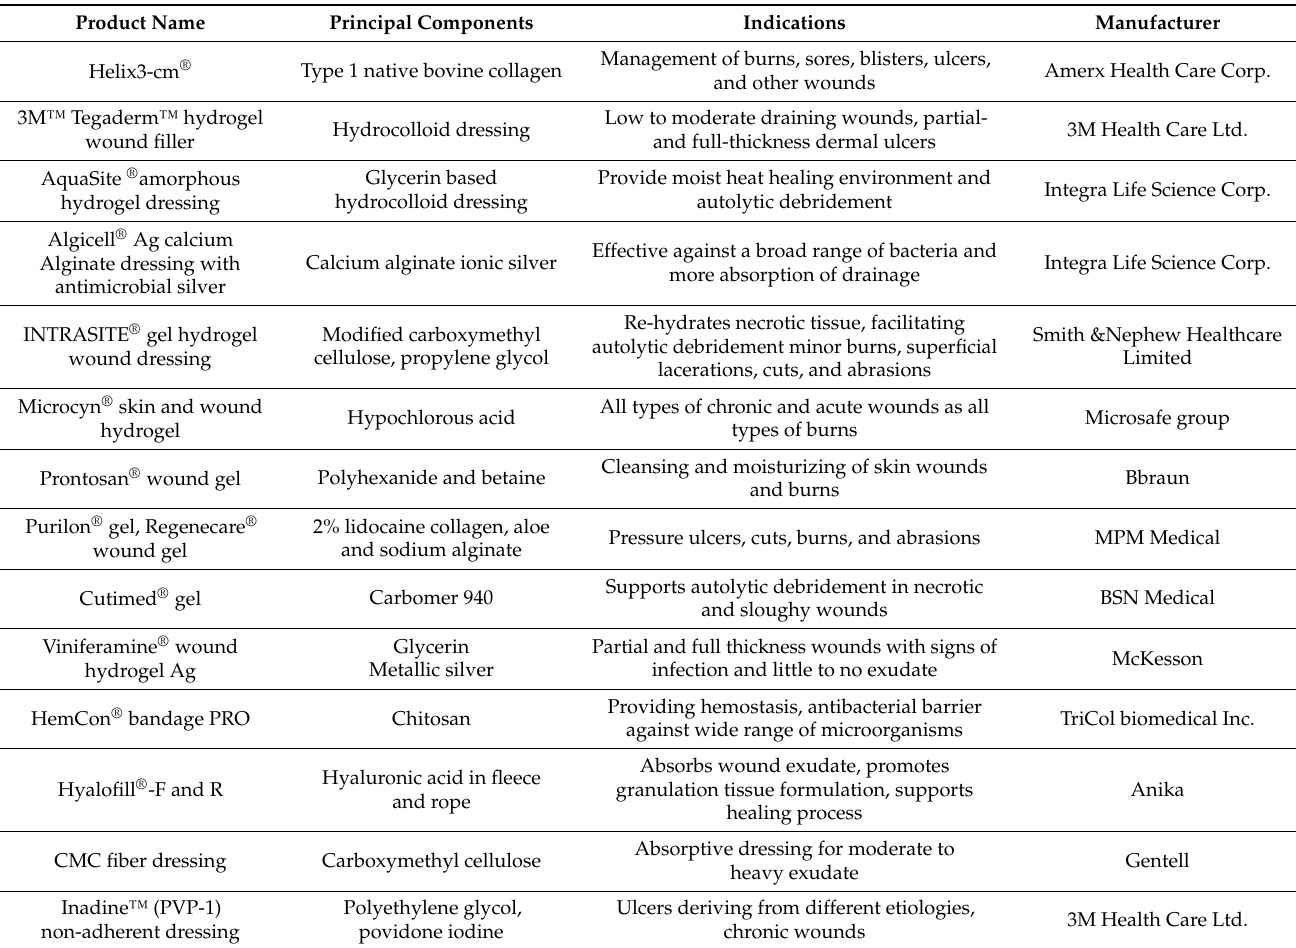
Table 5. Selected commercial examples of hydrogel-based wound dressing